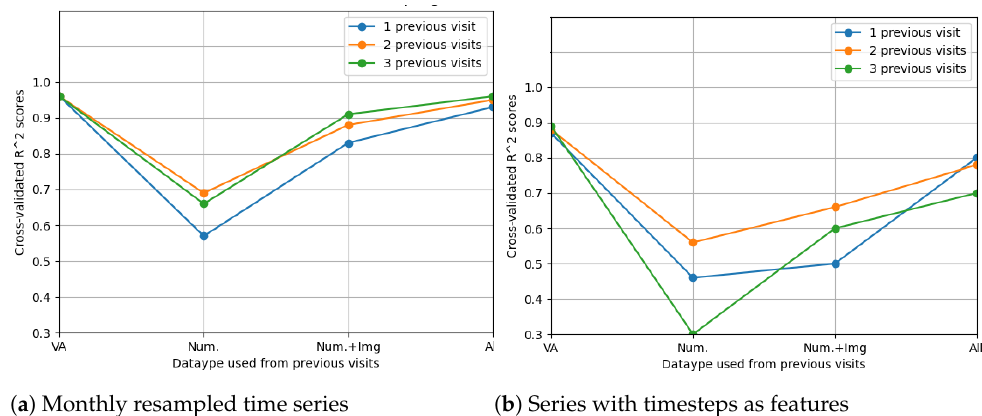
Figure 15. Comparison of feature selection methods’ performance when predicting future visual acuities from all OCT data. Average cross-validated R 2 scores for all neural networks were